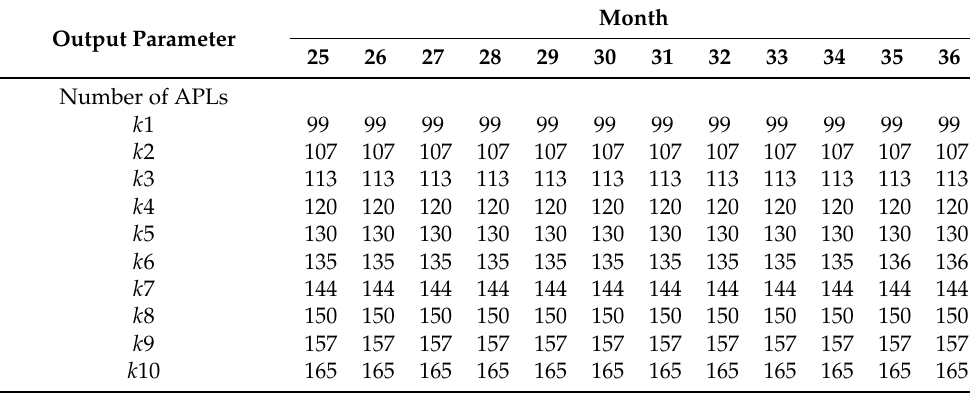
Table A6. Number of APLs in the third